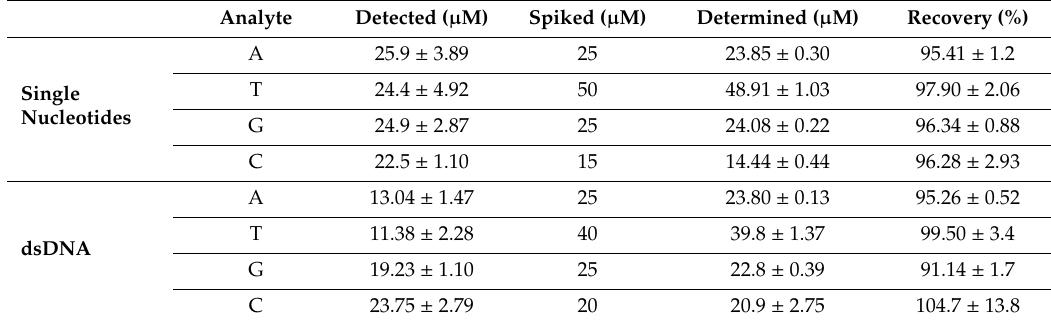
Table 3. Application of GCE / GONRs-CH for simultaneous determination of G, A, T and C in the two real samples of single nucleotides and dsDNA ( n = 4, for the reported RSD